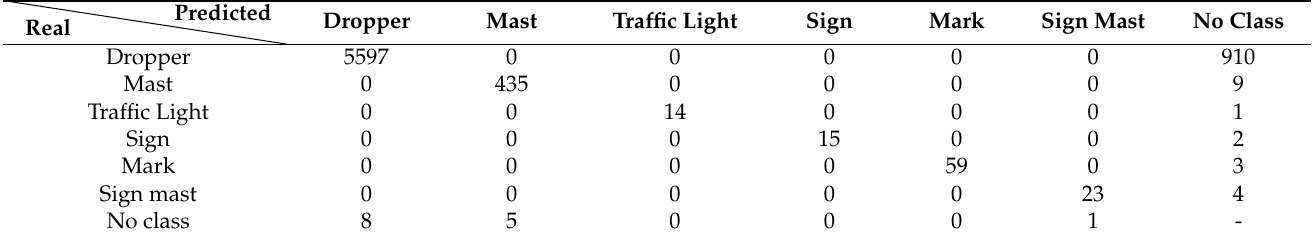
Table 4. Confusion matrix of point elements measured in number of